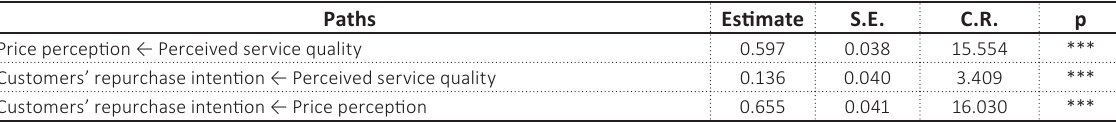
Table 8. Regression weights and mediation